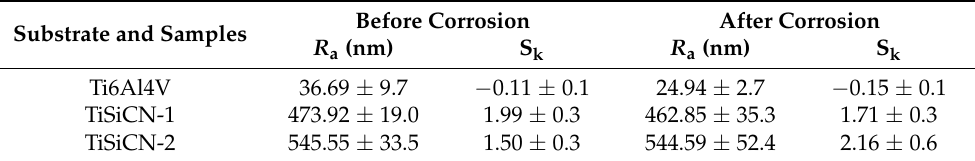
Table 2. Roughness parameters of the investigated surfaces before and after corrosion tests (R a — arithmetic average deviation from the mean line; S k —skewness factor). Before Corrosion After Substrate and Samples